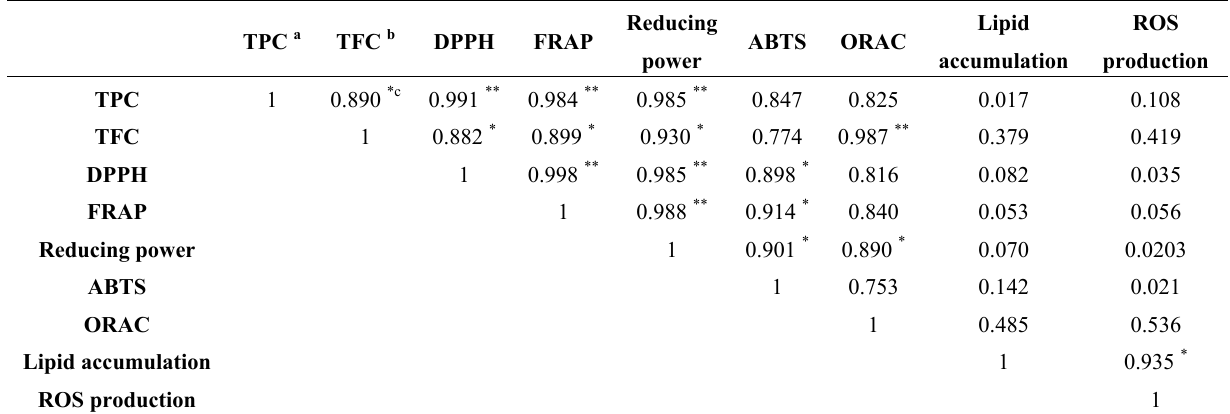
Table 2. Correlation coefficients (R) among total phenolics, total flavonoids and antioxidant capacity as well as lipid accumulation and ROS production in 3T3-L1 cells. Reducing Lipid ROS TPC a TFC b DPPH FRAP ABTS ORAC power accumulation production TPC 1 0.890 *c 0.991 ** 0.984 ** 0.985 ** 0.847 0.825 0.017 0.108 0.882 * 0.899 * 0.930 * 0.774 0.987 ** 0.998 ** 0.985 ** 0.898 * 0.816 0.082 0.035 1 0.988 ** 0.914 * 0.840 0.053 0.056 1 0.901 * 0.890